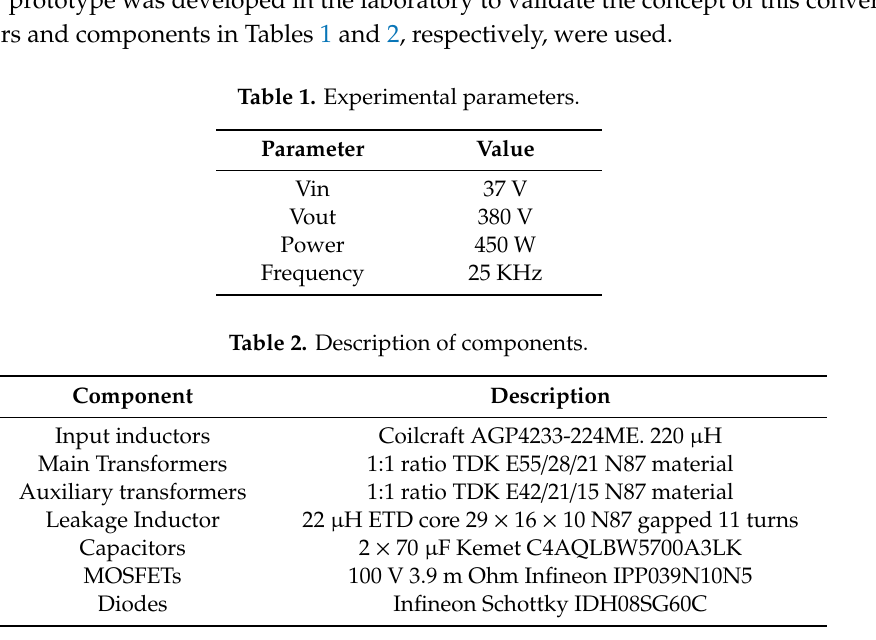
Table 1. Experimental parameters.